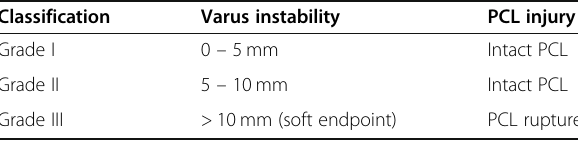
Table 2 The Hughston classification: classification of posterolateral instability assessed by varus instability